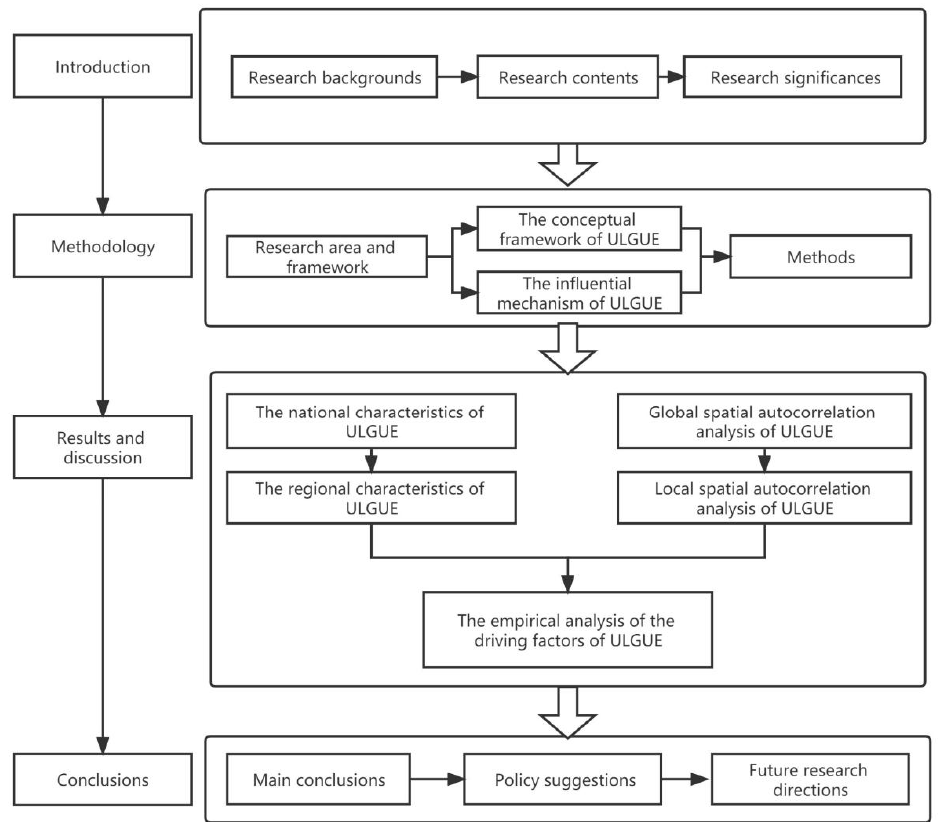
Figure 2. The framework of the empirical research of ULGUE in China.